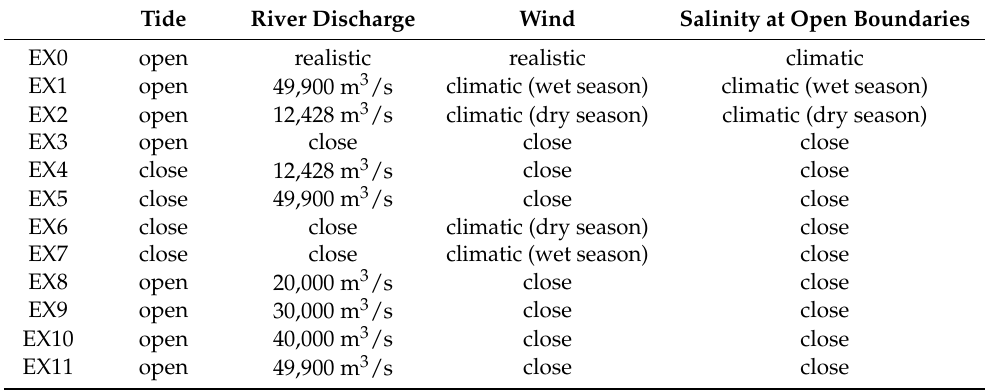
Table 3. Numerical experiment setting.